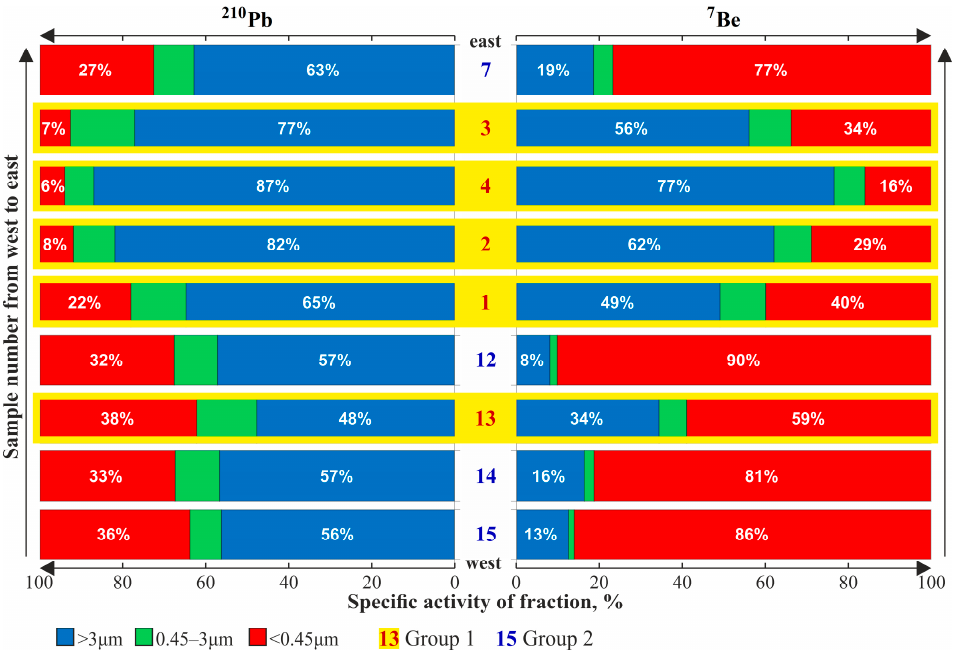
Figure 8. Cluster-mean 5-day backward air-mass trajectories calculated by the HYSPLIT model, including the percentages of each cluster trajectory during 2018–2019 winter period.